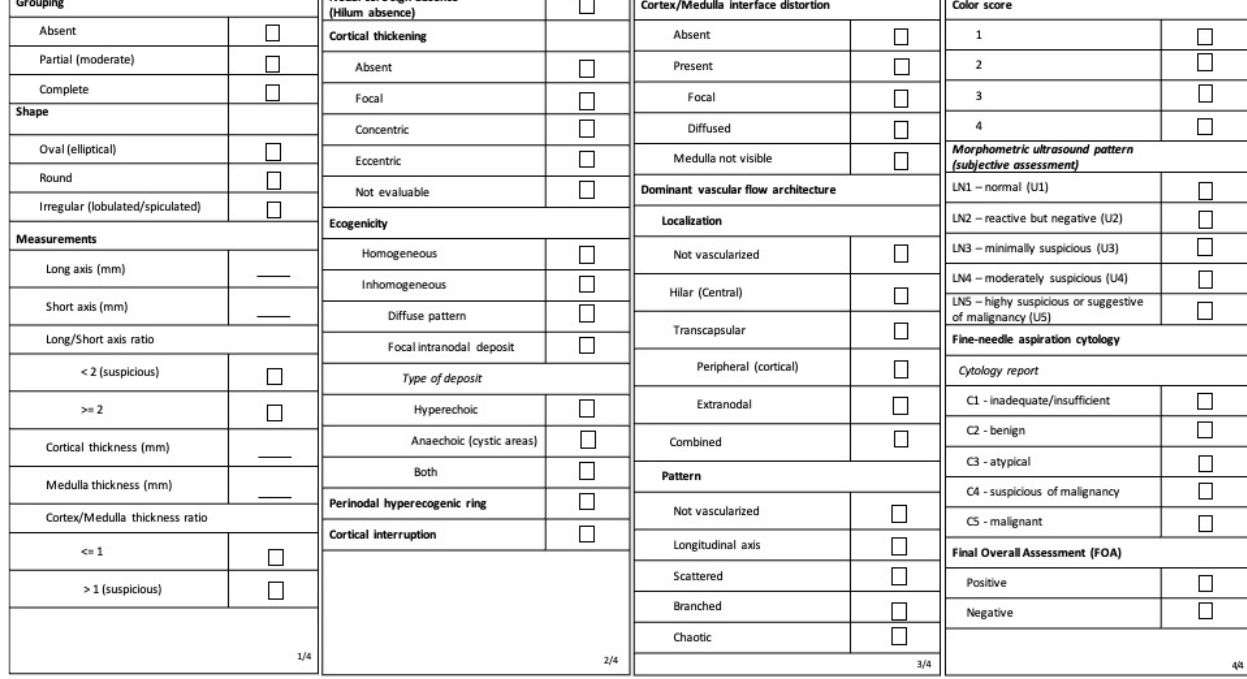
Figure 1. Ultrasound features registration form. All features are described according to VITA nomenclature. The corresponding terms previously used in the Morphonode Study are reported in